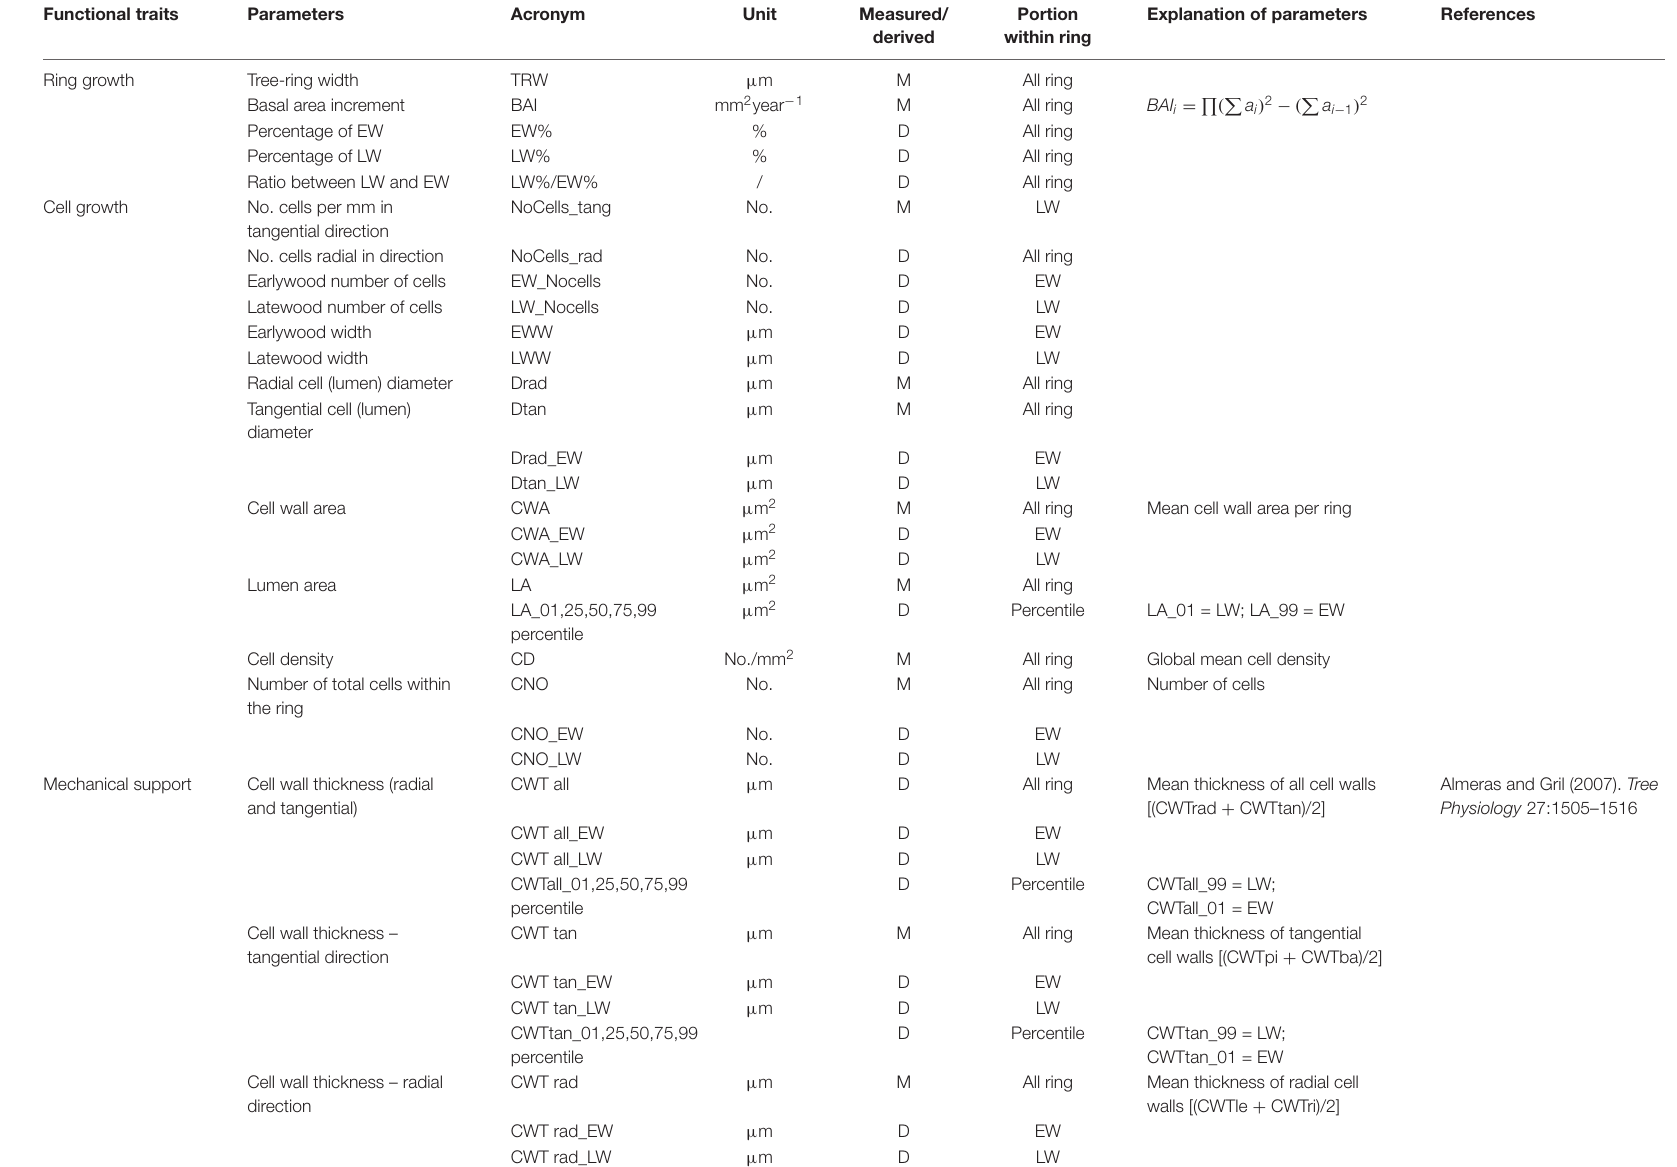
TABLE 2 | List of all wood anatomical traits used in this study, dividing by their